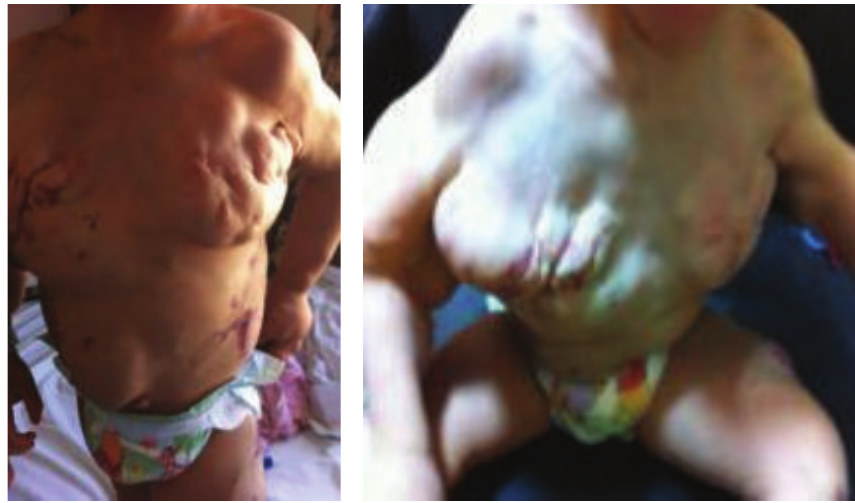
Figure 1: Focal overgrowth over the upper part of the chest.